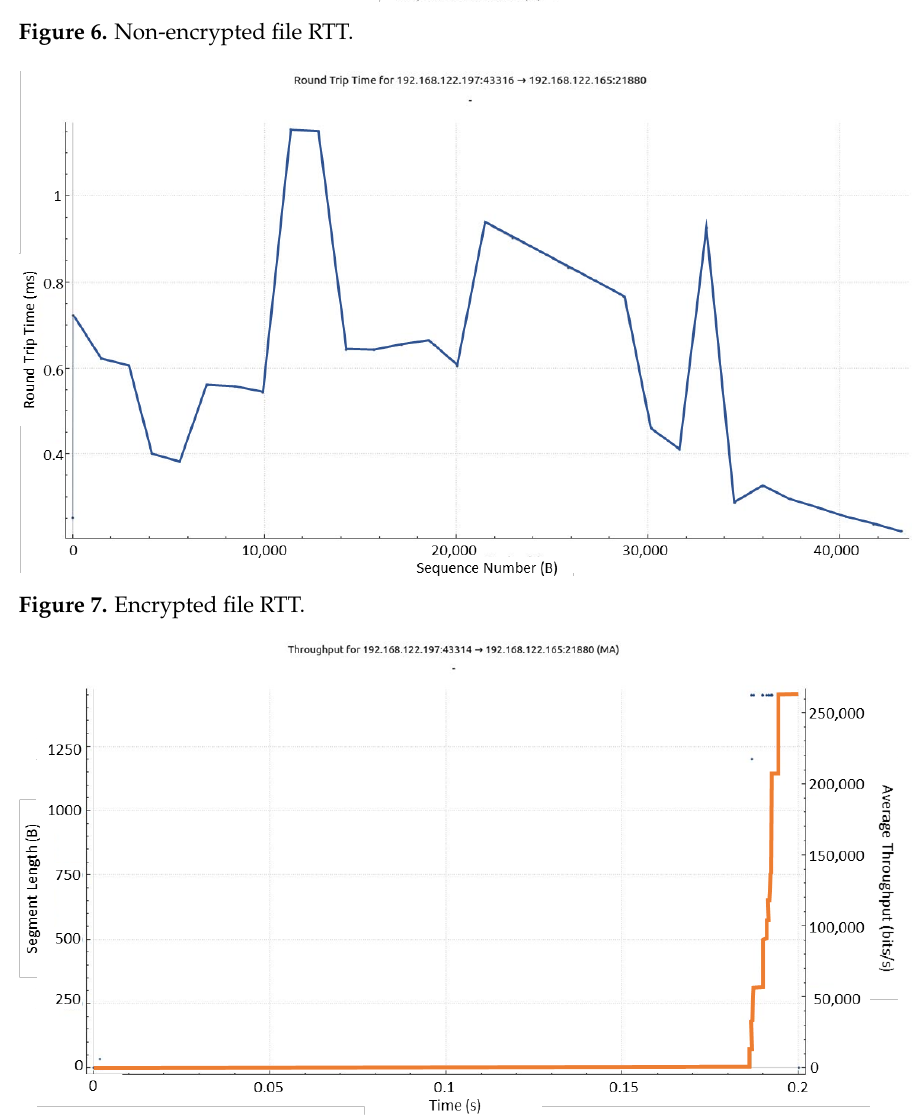
Figure 8. Non-encrypted file throughput.